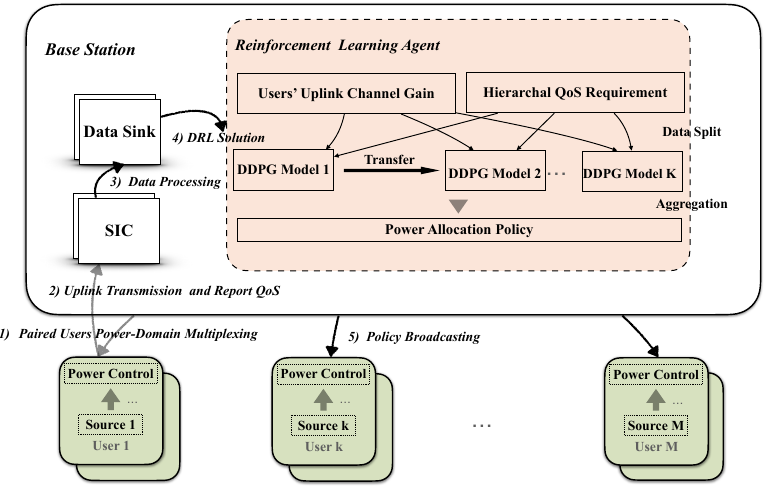
Figure 2. Flow chart of the Deep Deterministic Policy